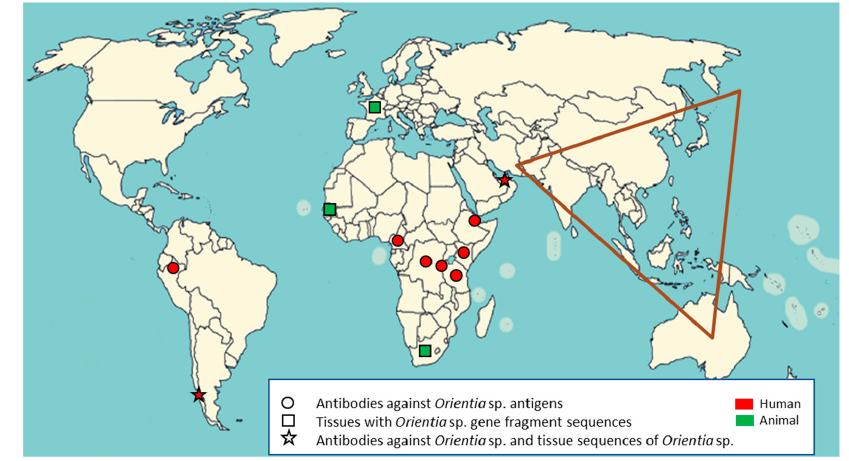
Figure 2. Human and animal serological and molecular evidence of Orientia spp. infections in new endemic regions of scrub typhus outside of the Tsutsugamushi Triangle (shown in brown).